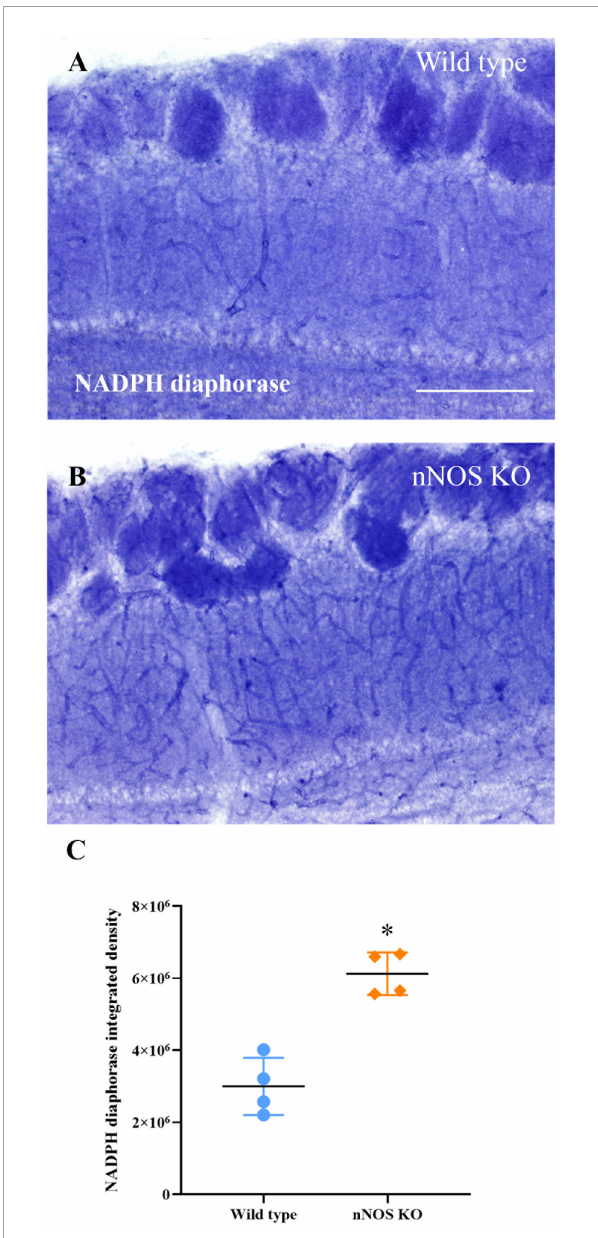
FIGURE5 Analysis of NADPH diaphorase activity. Labeling of NADPH diaphorase in blood vessels of wild-type (A) and nNOS-KO mice (B) . (C) Chart showing the analysis of NADPH diaphorase staining present in the blood vessels of both animal models; note that nNOS-KO mice show more intense labeling in comparison with the wild-type animals (wild type 2999976.75 ± 796295.55 integrated density/mm 2 ; nNOS KO 6126408.75 ± 592378.10 integrated density/mm 2 ; p = 0.029). ∗ p < 0.05. Scale bar 200 µ m.